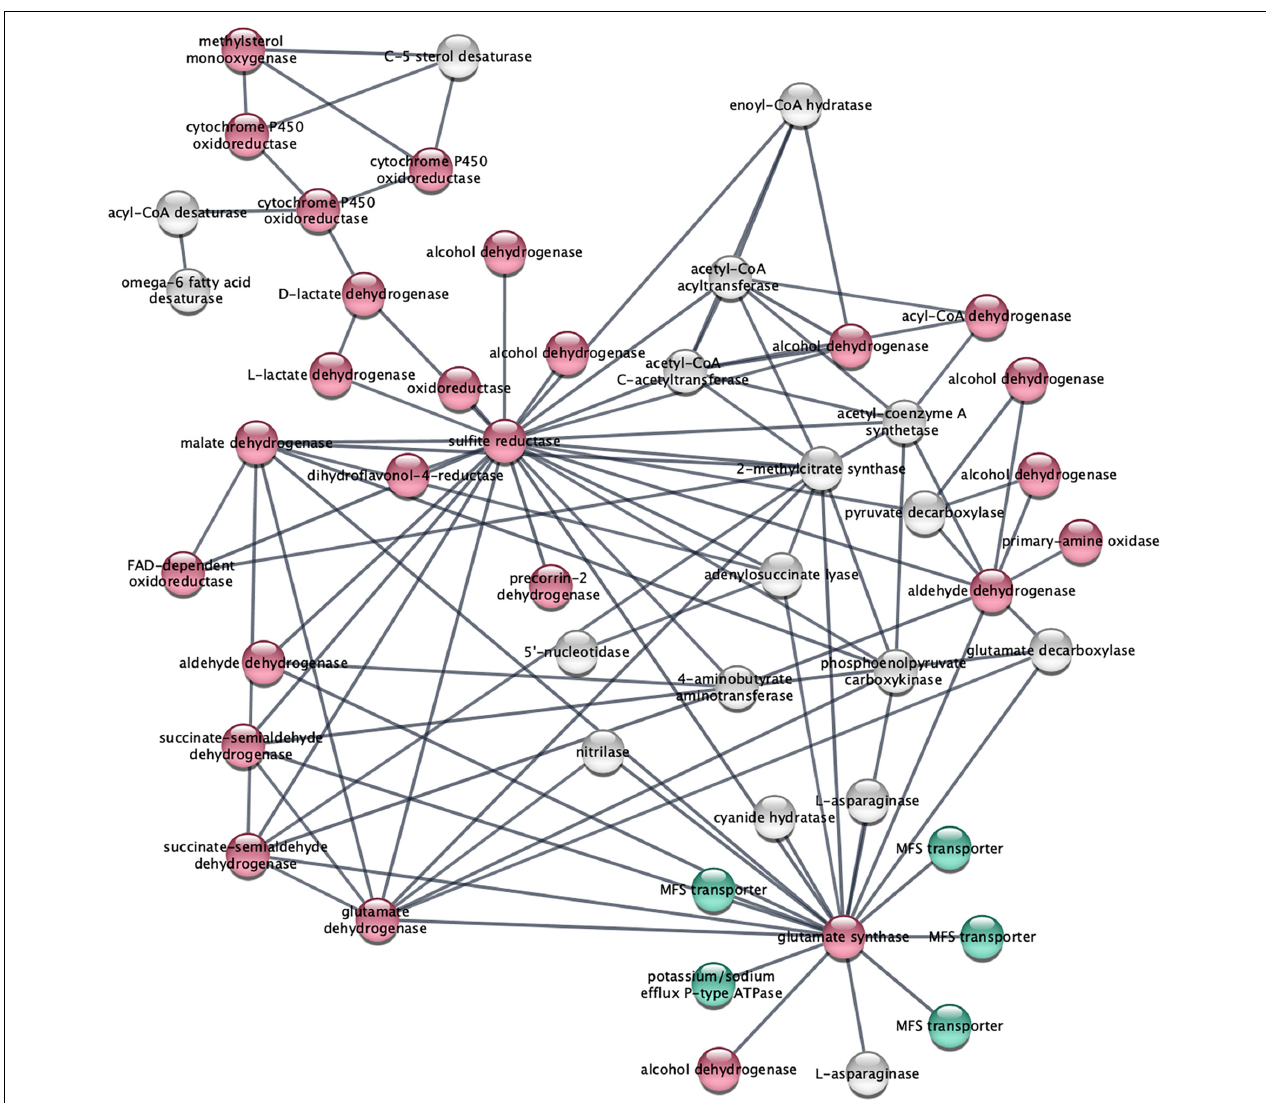
FIGURE 4 | STRING analysis of upregulated genes depicts a network of dehydrogenase genes, with sulfite reductase (FOXG_10442) and glutamate synthase (FOXG_11281) in the center. Upregulated genes following NA exposures were analyzed using the STRING platform as described in Materials and Method. Nodes colored in red are oxidoreductases; nodes colored in green are transport proteins. The gene IDs that match the gene descriptions presented in the figure are found in Supplementary Table S3